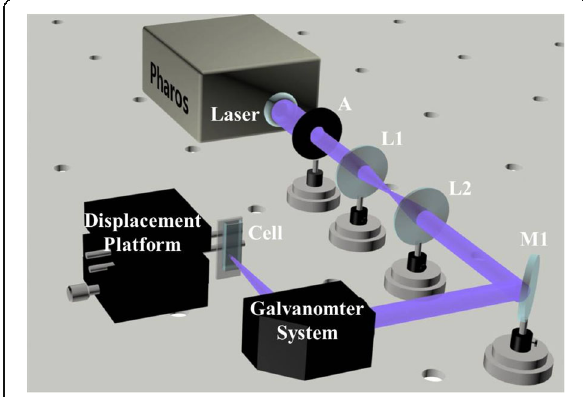
Fig. 1 The experimental scheme for femtosecond laser ablation diamond bulk in